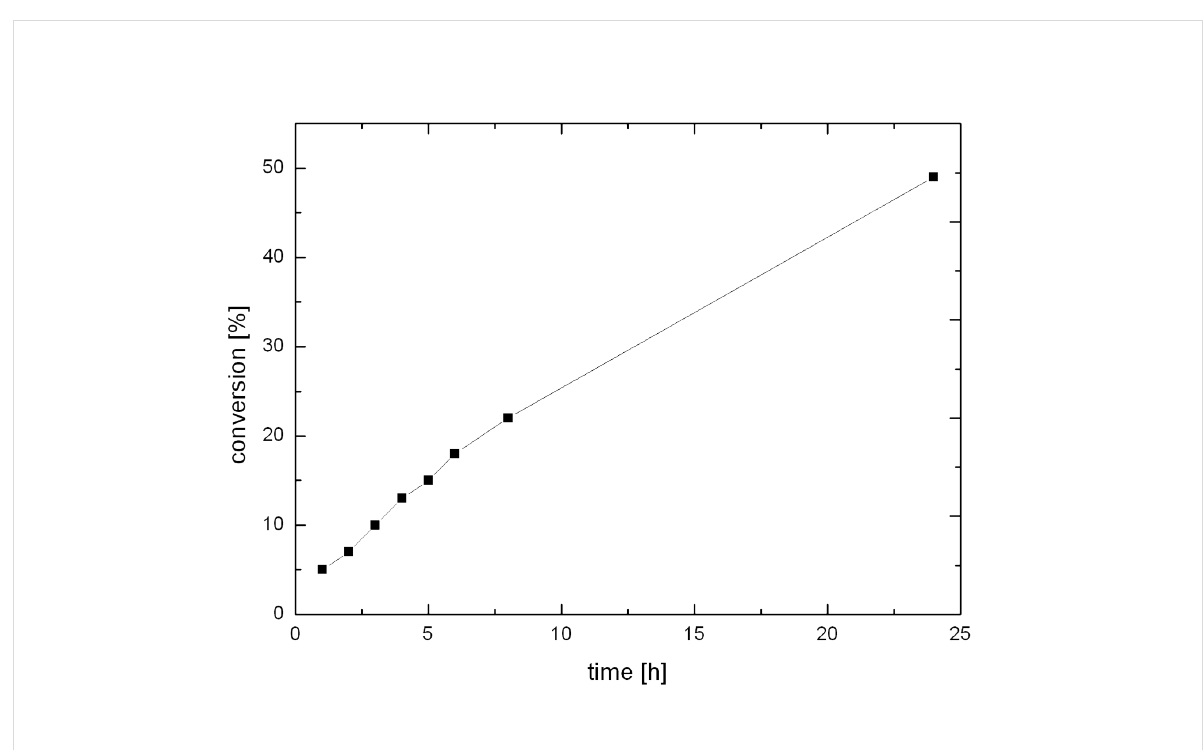
Figure 3: Conversion during the oxidation of ketone 6 in a two-liquid phase system over the time. The catalyst shows no decrease in activity for at least ten hours.